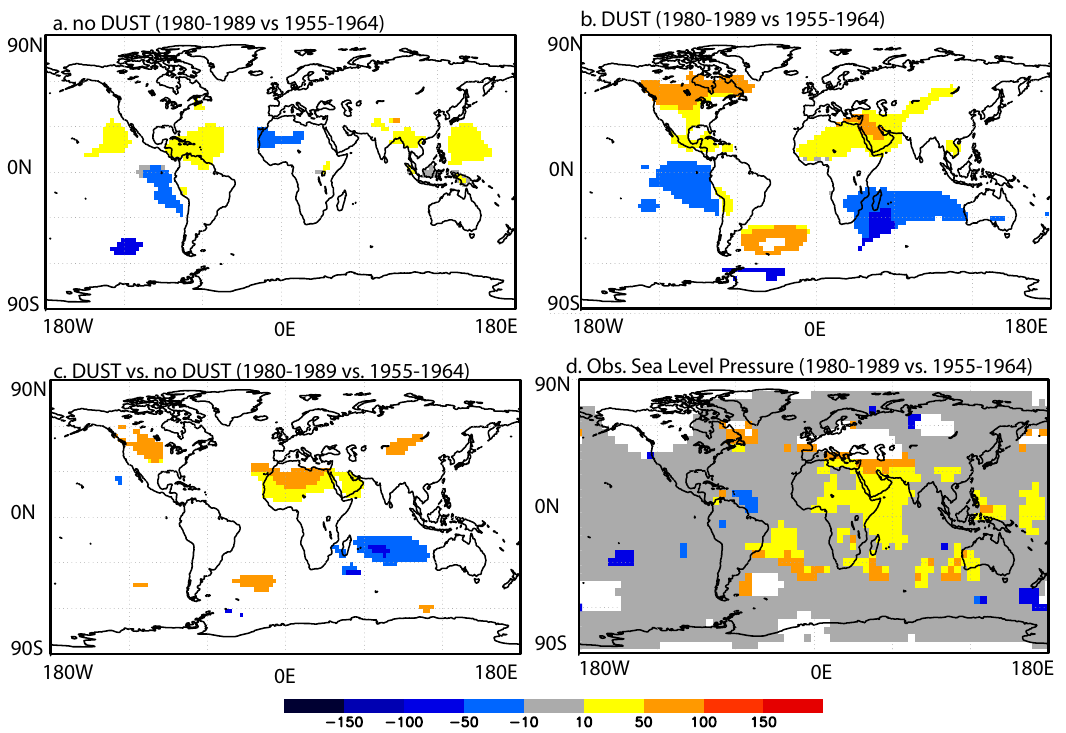
b. DUST (1980-1989 vs 1955-1964)a. no DUST (1980-1989 vs 1955-1964)